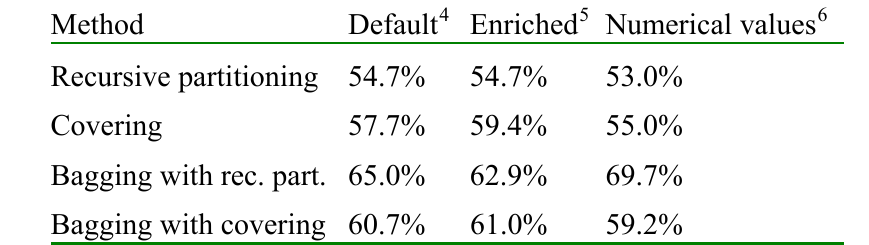
Table 2 . Prediction performance on the Paired domain using different methods and data representations (597 data points). The performance was evaluated by 5-fold